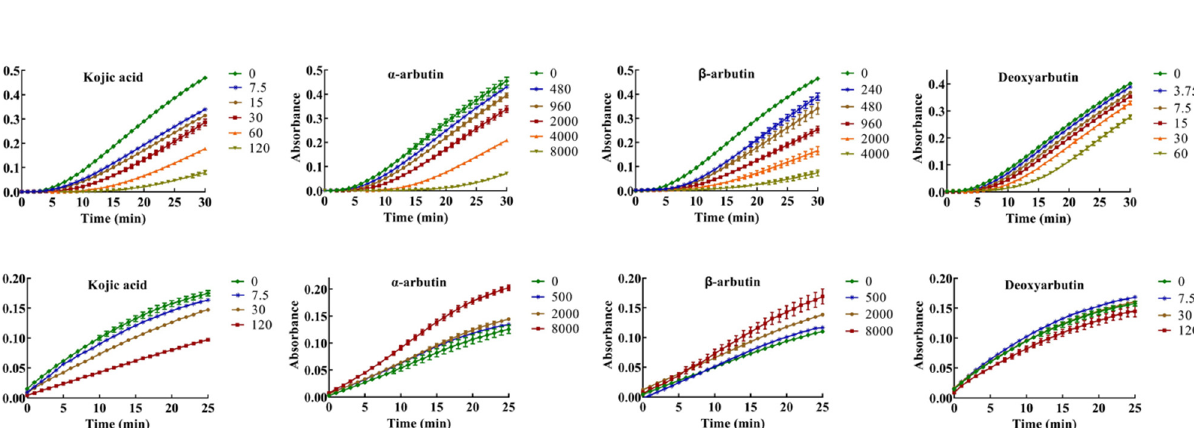
Figure 3. IC 50 value of kojic acid, α -arbutin, β -arbutin, and deoxyarbutin on monophenolase and diphenolase of MTYR. ( A ) Inhibition rate of monophenolase by compounds; ( B ) Inhibition rate of diphenolase by compounds; ( C ) IC 50 value of compounds on monophenolase and diphenolase. If the inhibition rate was negative, it meant the tyrosinase was activated. The activation rate was the absolute value of inhibition rate. 3.2. Kinetic Analysis on Monophenolase In this experiment, constant concentration of enzyme and changed concentration of L-tyrosine were used to measure the effects of different concentrations of compounds on monophenolase activity. Lineweaver–Burk plot was used to display the inhibition type. The plots of 1/V versus 1/[S] gave a series of lines with different slopes and intersecting at the y -axis (Figure 4). Enzyme kinetic analysis indicated that kojic acid was a competitive inhibitor (intersection on y axis), V max remained constant and K m increased with increasing concentrations of kojic acid, so too with α -arbutin. When at moderate molarity (250–1000 µM), K m increased, but V max remained constant with increasing concentration of β -arbutin,